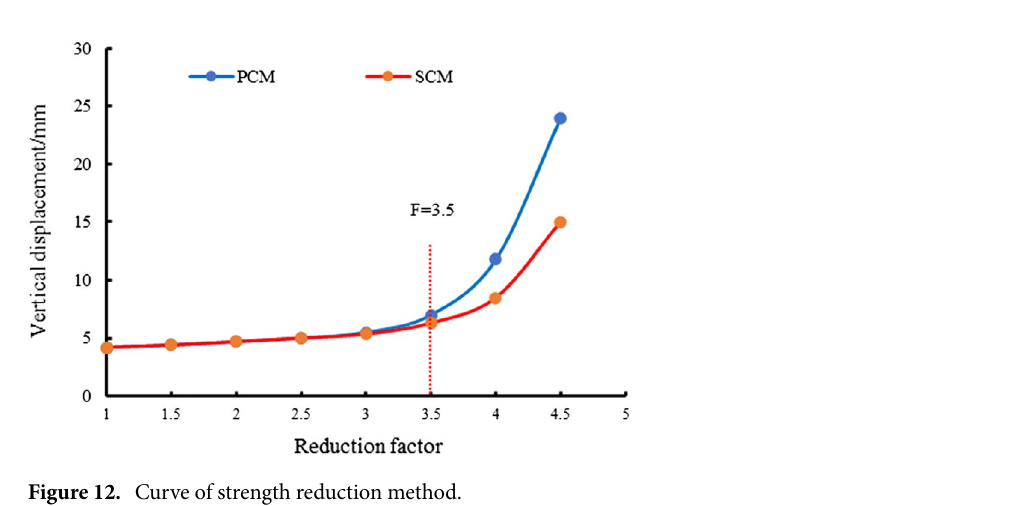
Figure 12. Curve of strength reduction